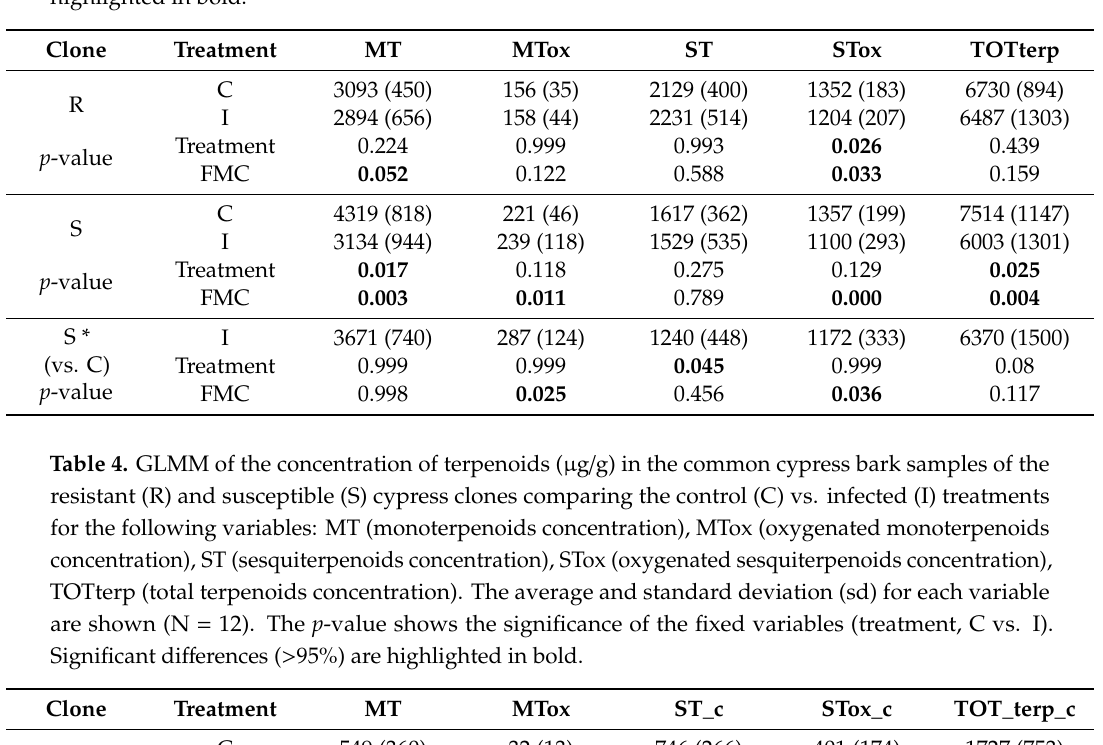
Table 3. GLMM on the concentration of terpenoids ( µ g / g) in the common cypress leaf samples of the resistant (R) and susceptible (S) cypress clones comparing the control (C) vs. infected (I) treatments for the following variables: MT (monoterpenoids concentration), MTox (oxygenated monoterpenoids concentration), ST (sesquiterpenoids concentration), STox (oxygenated sesquiterpenoids concentration), TOTterp (total terpenoids concentration). Fuel moisture content (FMC) is used as a covariable. Model for the SI treatment was repeated removing the dead samples *. The average and standard deviation (in brackets) for each variable are shown (N = 12). The p -value shows the significance of the fixed variables (treatment, C vs. I) and covariable (FMC) predictors. Significant di ff erences ( > 95%) are highlighted in bold.